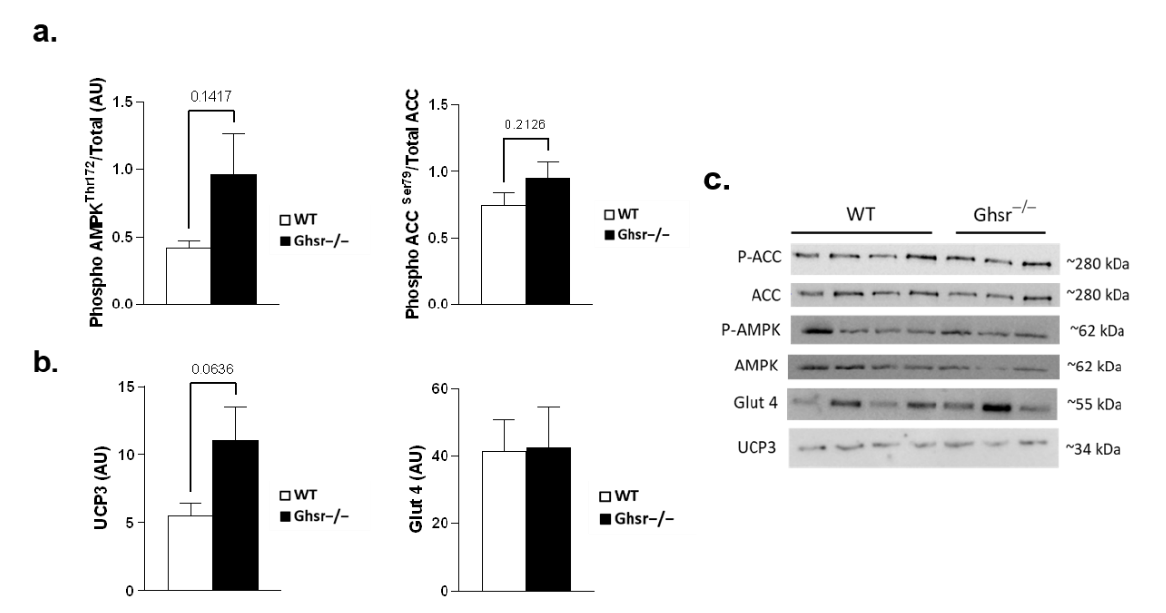
Figure 3. Effects of GHS-R ablation on protein markers of metabolic functions in aging muscle. Gastrocnemius muscle of old (18–26 m) WT (open bar, n = 4) and Ghsr − / − (black bar, n = 3) mice is shown. ( a ) Activation of AMPK and ACC expressed as phosphorylated to total protein ratios. ( b ) Total Protein expression of UCP3 and Glut 4 in gastrocnemius muscle. ( c ) Representative images for AMPK, ACC, UCP3 and Glut 4. Two-tailed Student’s t -tests were performed, and data are presented as means ± standard error.